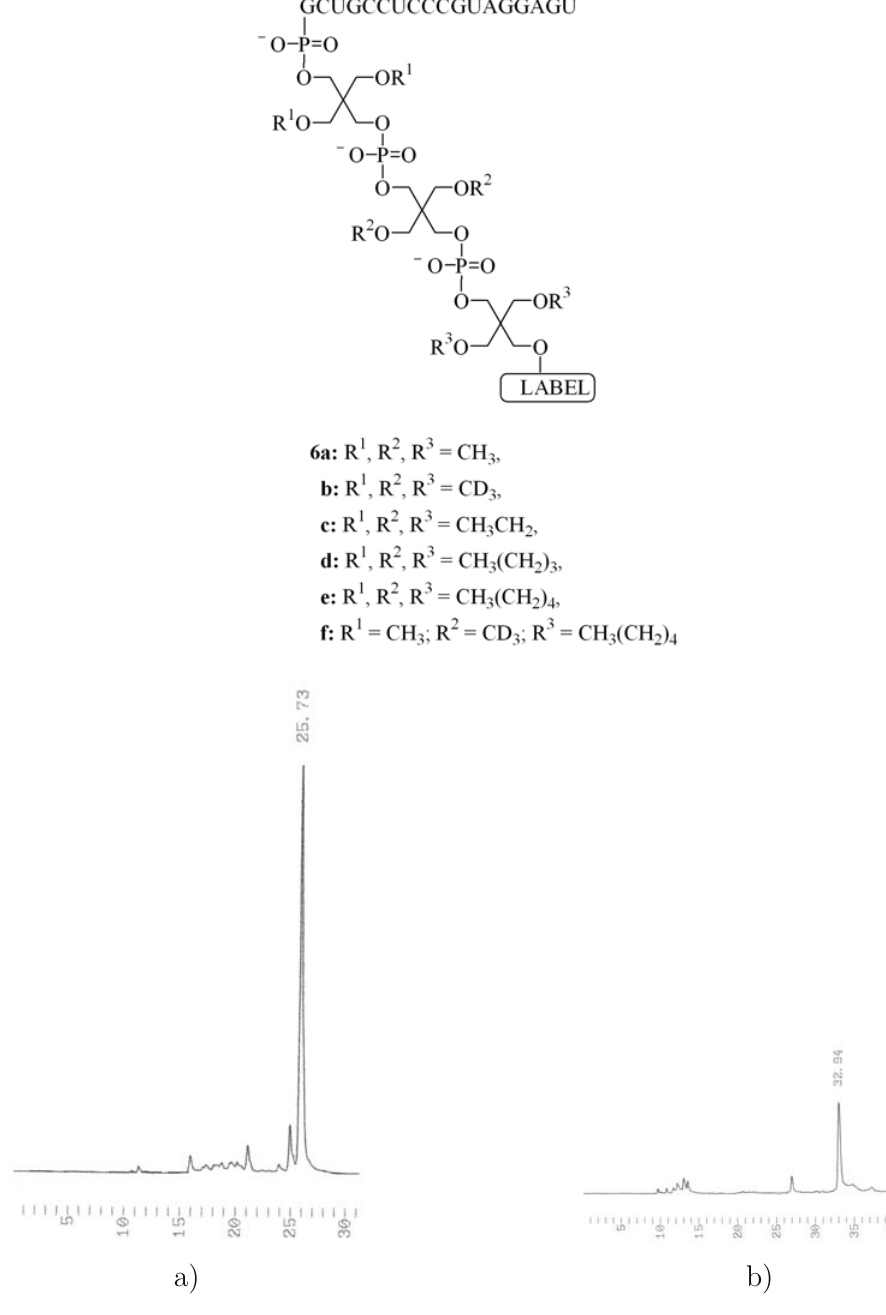
Fig. 1 RP HPLC profile of crude 6a (a) and 6e (b) at 260